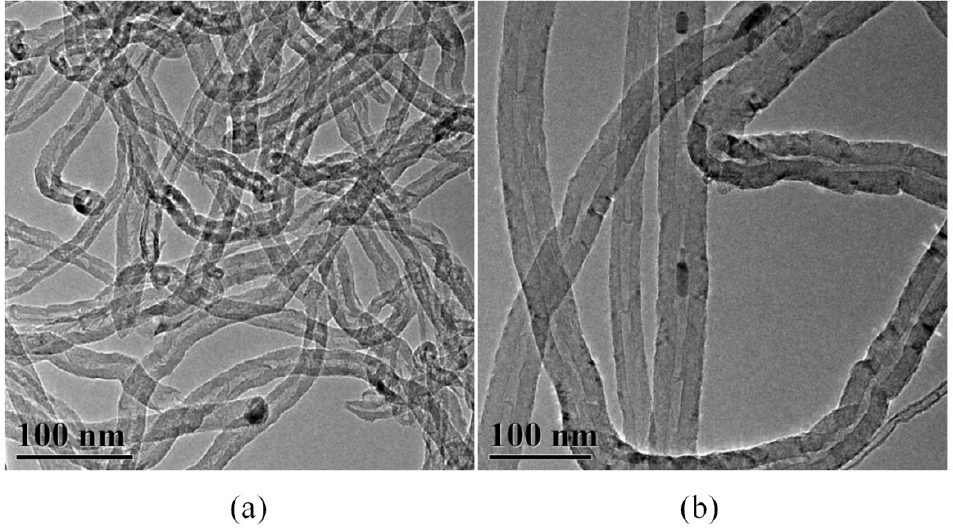
Figure 2. TEM images of CNTs ( a ) and CNTs-PMDA ( b ).